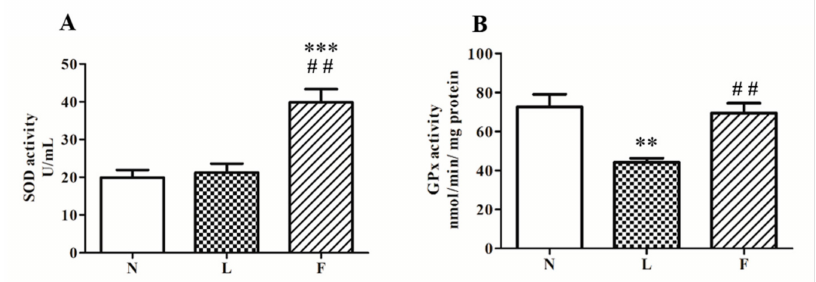
Figure 4. Antioxidant activities. Superoxide dismutase (SOD) ( A ) and glutathione peroxidase (GPx) ( B ) activities were detected on total testis homogenates. Data were graphically represented as mean ± SEM of eight di ff erent animal for each group. Significant di ff erences are shown: ** p < 0.01 vs. N; *** p < 0.001 vs. N, ## p < 0.01 vs.